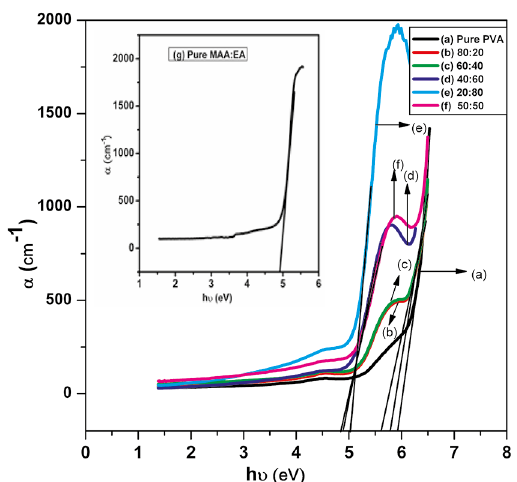
Figure 12. α vs hυ curves of pure and PVA/MAA:EA samples (a) Pure PVA (b) 80:20 (c) 60:40 (d) 40:60 (e) 20:80 (f) 50:50 (g) Pure